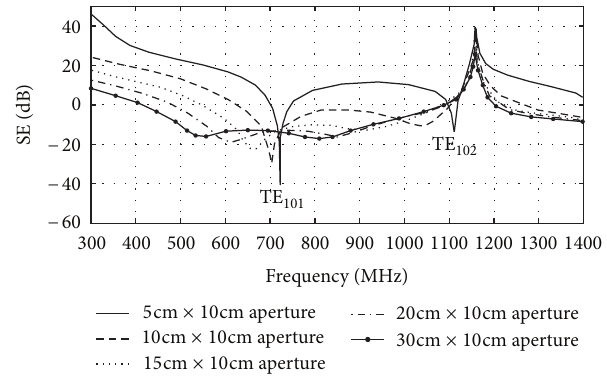
F 5: Shielding effectiveness versus frequency at the center of a box-shaped enclosure of dimensions (30 rectangular aperture of different